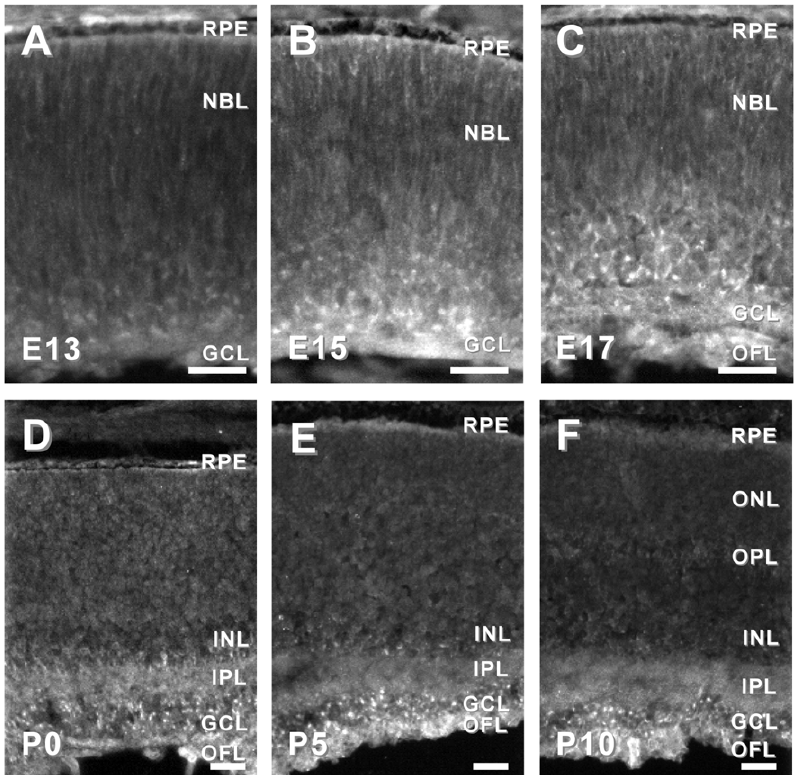
Figure 2. Dynamic protein expression of APLP2 in developing mouse retina. APLP2-IR in the E13 mouse retina was slightly more intense in cells in the inner and outermost retina (A). In the E15 mouse retina (B), APLP2-IR was observed throughout the thickness of the retina, though the most intense immunoreactivity remained localized to cells in the in the inner and outermost retina. By E17, APLP2-IR was largely restricted to cells and processes in the inner one-third of the retina (C). By the day of birth (P0), APLP2-IR was restricted to cell bodies in the ganglion cell layer (GCL), the IPL and the inner nuclear layer (INL). In the P5 retina, APLP2-IR was most prominent in the IPL, GCL and OFL, though some punctate APLP2-IR remained in the INL (D). By P10, APLP2-IR was further restricted to the IPL and OFL, with punctate immunoreactivity only present in the GCL. Abbreviations: GCL, ganglion cell layer; INL, inner nuclear layer; IPL, inner plexiform layer; NBL, neuroblastic layer; OFL, optic fiber layer; ONL, outer nuclear layer; RPE, retinal pigment epithelium. Bars, 30 m m.